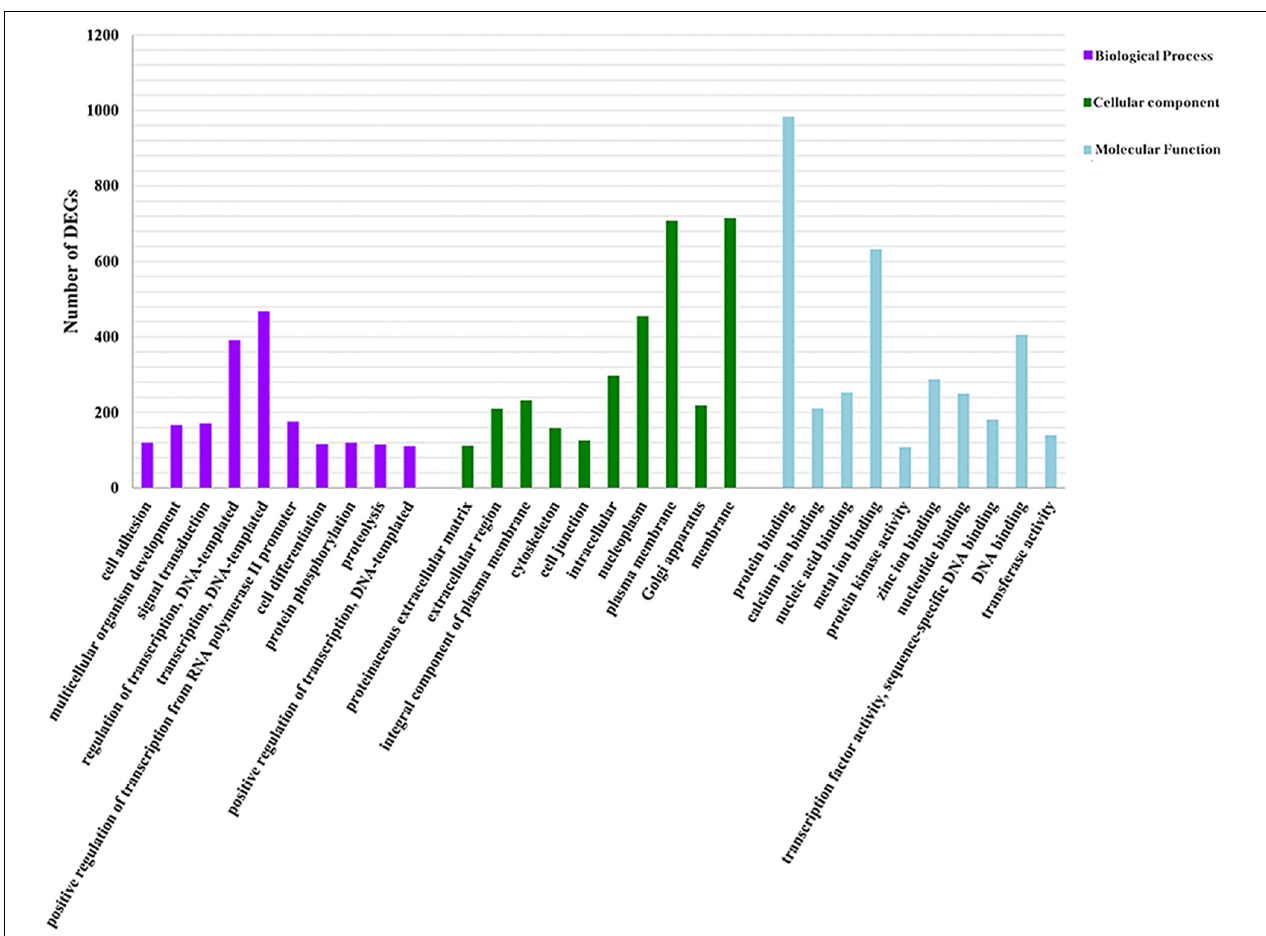
FIGURE 5 | GO analysis of DEGs. Distribution of level-3 GO annotation among the three categories. The y -axis represents the corresponding number of DEGs; the x -axis stands for the gene function classification based on